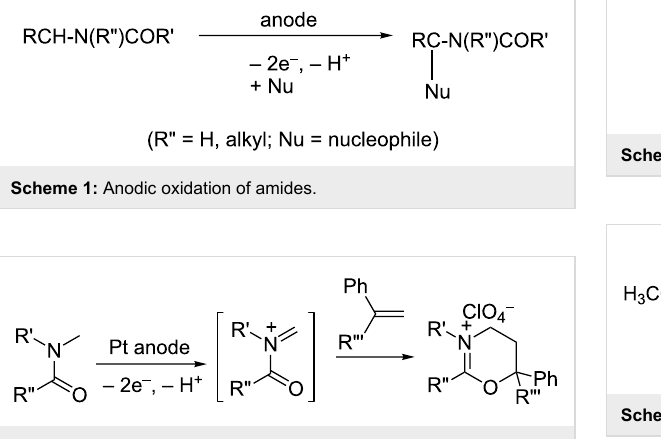
Scheme 2: Anodic oxidation of an amide in the presence of alkene.